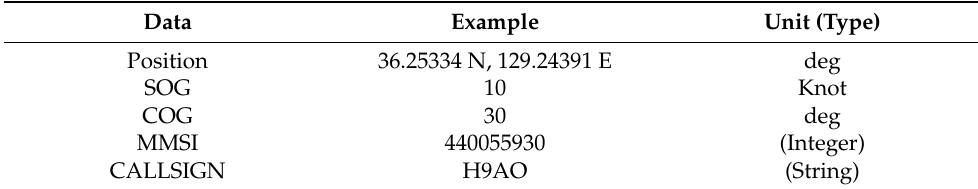
Table 2. Ship AIS data.